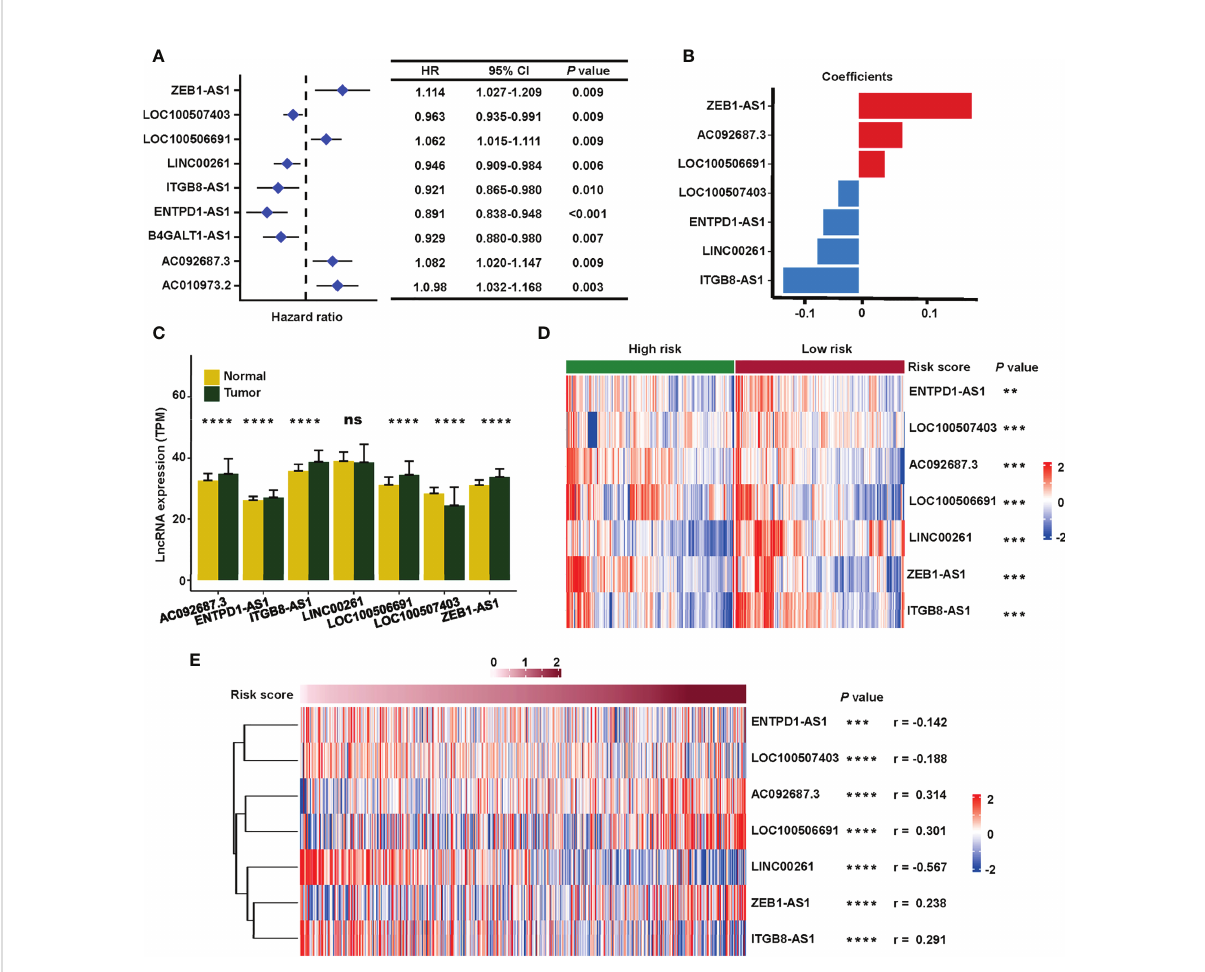
FIGURE 2 Construction of the sialylation-related lncRNA signature. (A) HR and CI of nine lncRNAs with P < 0.001 in a univariate Cox regression for OS. (B) Coef fi cients of the seven lncRNAs in the prognosis signature. (C) Expression of the lncRNAs in normal (n = 51) and cancer (n = 543) tissues in the TCGA dataset. (D) Expression pro fi les of the lncRNAs in high- and low-risk patients in the combined cohort. (E) Correlation of the expression of seven sialylation-related lncRNAs with risk scores by the Spearman test. HR, hazard ratio; CI, con fi dence interval; and OS,